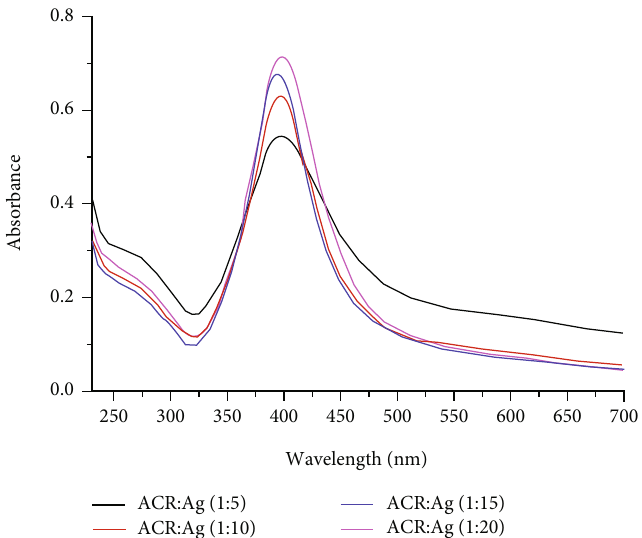
Figure 2: UV-visible spectra of acridine-coated silver nanoparticles (ACR-AgNPs).